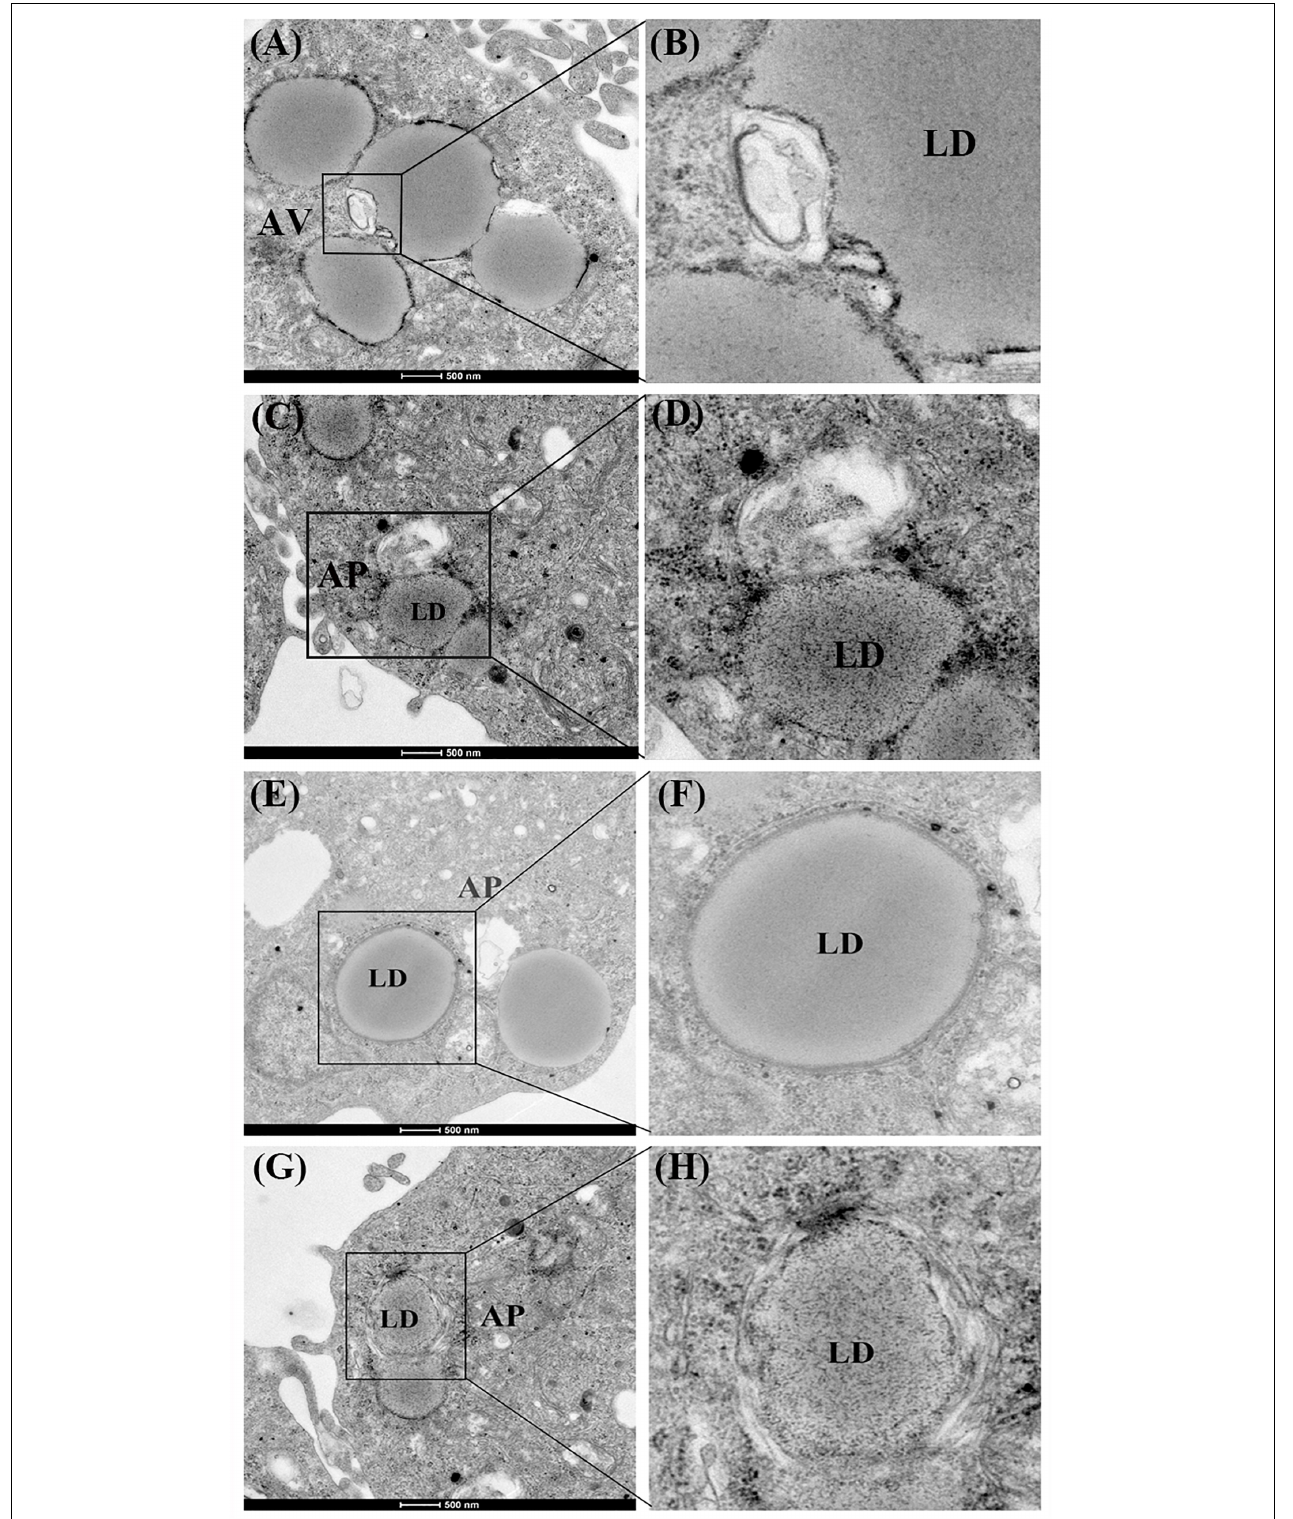
FIGURE 2 | Electron micrographs of ZFL cells. (A,B) The structure of an autophagic vesicole (AV). (C–H) The structure of an autophagosome containing a lipid droplet (AP). N, nucleus; ER, endoplasmic reticulum; Mit, mitochondria.